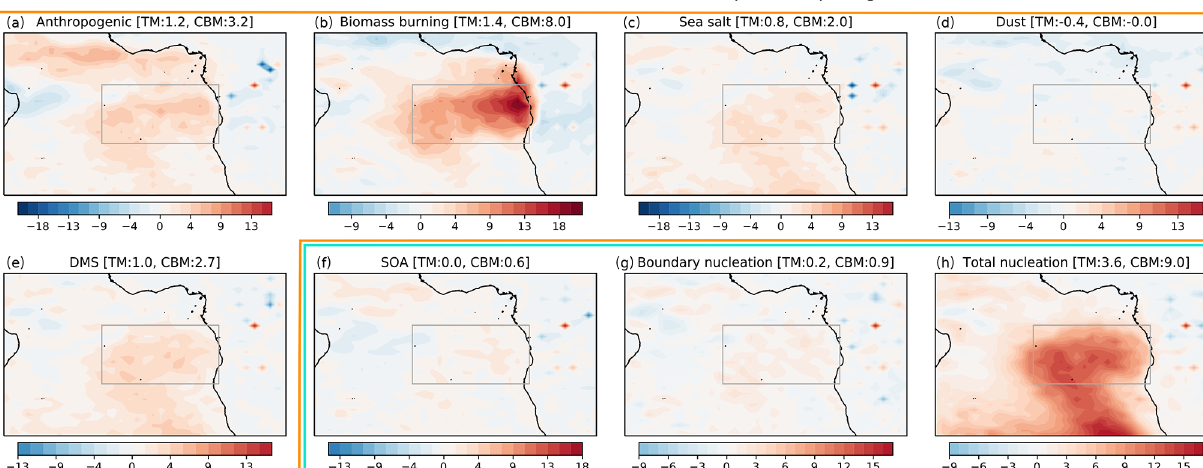
https://doi.org/10.5194/acp-22-10789-2022 Atmos. Chem. Phys., 22, 10789–10807,